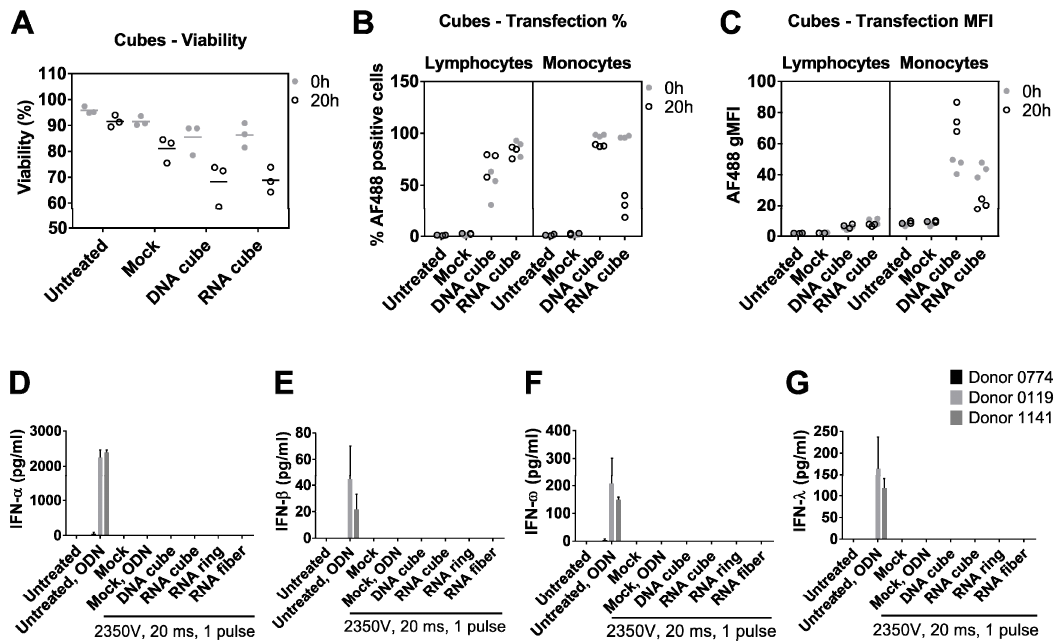
Figure 4. Electroporation of PBMCs with NANPs with a 2350 V, 20 ms pulse. ( A ) Electroporation slightly reduced PBMC viability as measured by acridine orange (AO) and propidium iodide